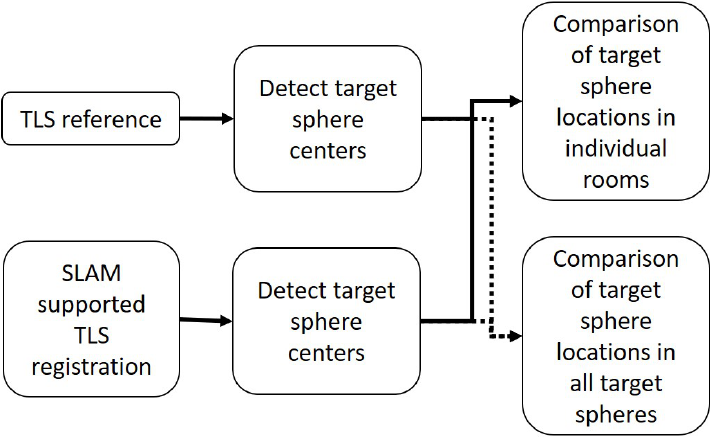
Figure 9. The process of the target sphere comparison between the SLAM registered TLS room point cloud and reference point clouds (TLS reference_room ) for individual rooms and merged rooms.